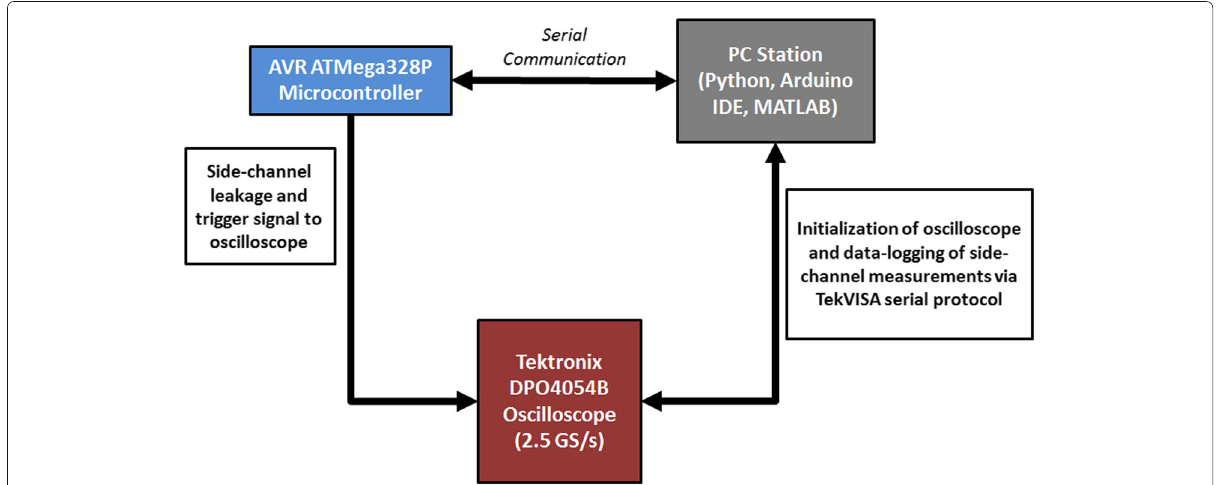
Fig. 4 Diagram of the experimental setup. PC oscilloscope serial communication interface to extract side channels from target device